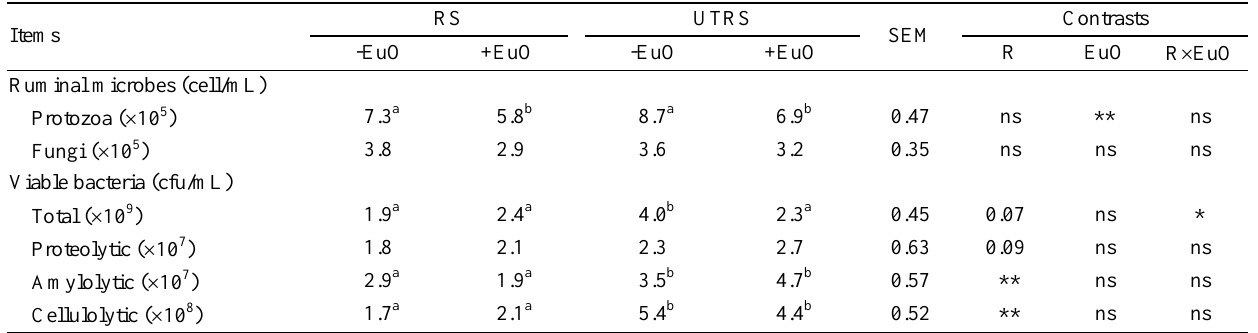
Table 4. Effects of roughage sources and Eucalyptus oils supplementation on microbial population